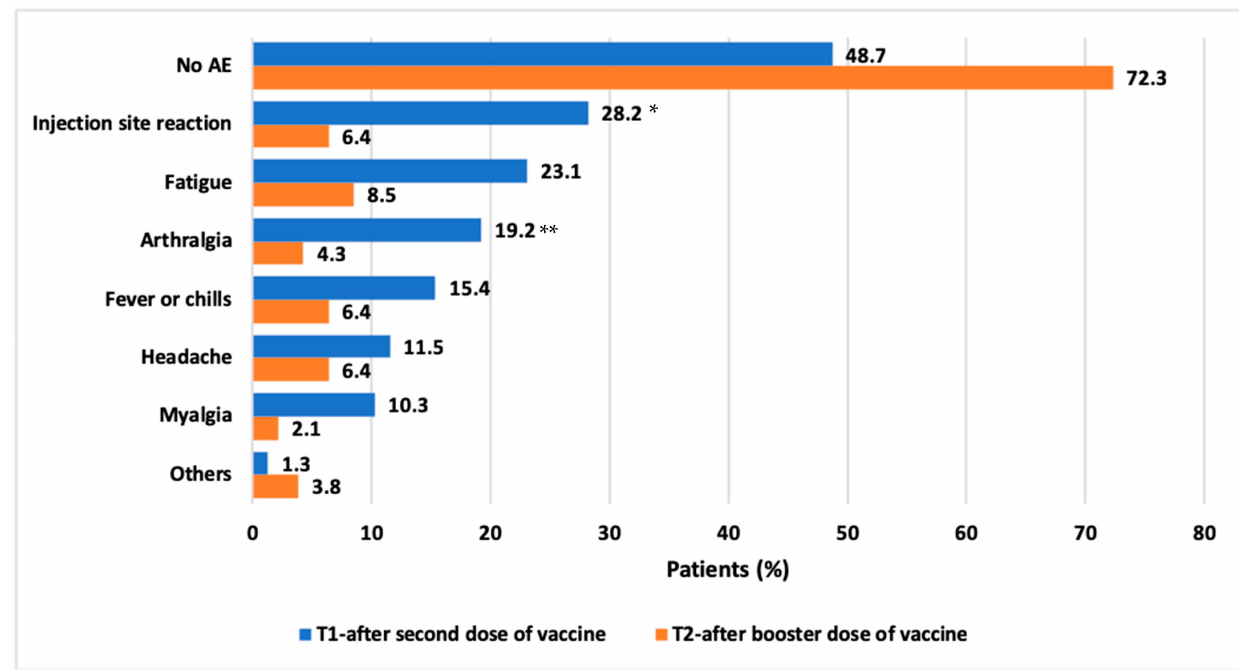
Figure 1. Rate of adverse events following the second dose (78 patients) and the booster dose (47 patients) COVID-19 vaccination in patients with rheumatoid arthritis. * p < 0.007; ** p <